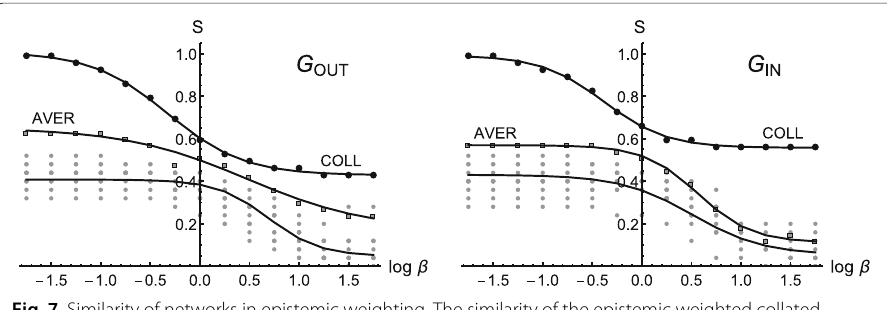
Fig. 7 Similarity of networks in epistemic weighting. The similarity of the epistemic weighted collated network to the unweighted collated (COLL, black circles) network with β (cid:5) 1 is shown by the uppermost curves for out-going (OUT) links at the left and for in-coming links (IN) at the right. The similarity based on the averaged values of the communicabilities (AVER, gray squares) compared to the values from the collated network, with same value of epistemic weight β , is shown by the second curve from the top. The gray dots show the distribution of the similarities of the 12 individual networks. The fitting curve (the lowest curves) show the average value corresponding to the 12 individual